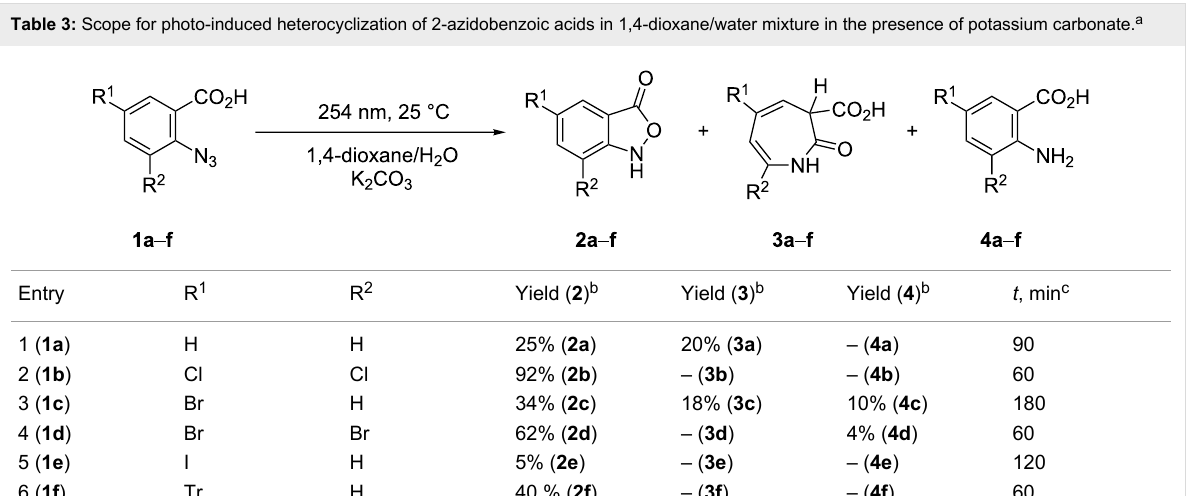
Table 3: Scope for photo-induced heterocyclization of 2-azidobenzoic acids in 1,4-dioxane/water mixture in the presence of potassium carbonate.